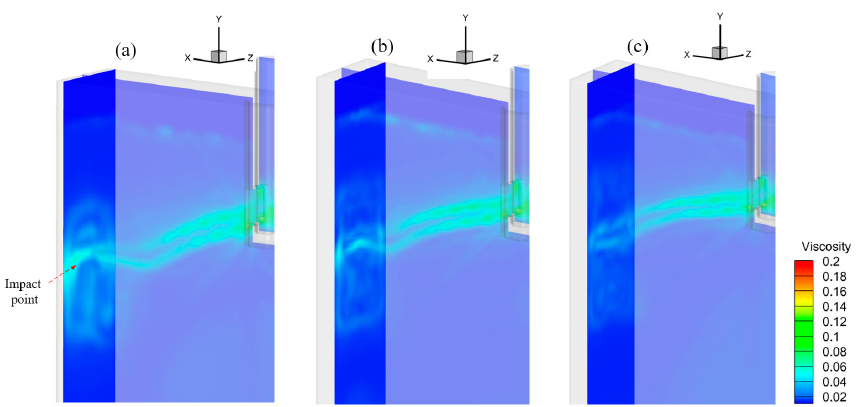
Figure 7. Effective viscosity of steel around the jet flow and the vortex structures along width wall on the center-plane of the mold at different stages: ( a ) before the impact; ( b ) during the impact; ( c ) after the impact.